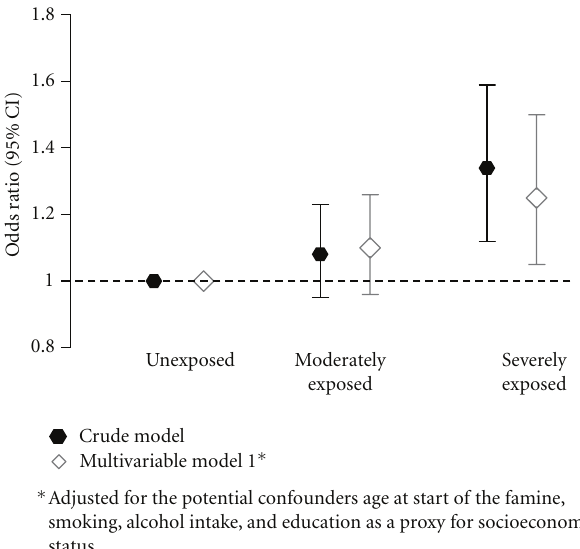
Figure 1: Odds ratios (ORs) and 95% confidence intervals (CI) for the risk of overweight (BMI ≥ 25kg/m 2 ) for women within the 0- to-9-year exposure age category who reported to be moderately or severely exposed to famine compared to those who reported to be unexposed to